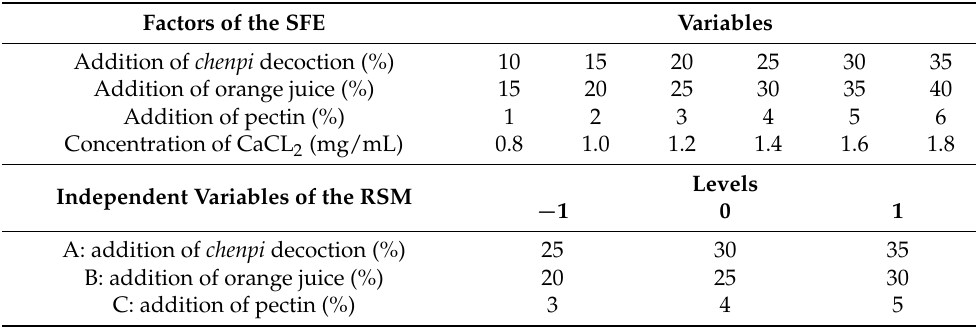
Table 2. Variables and the range of values for the SFE and RSM. Factors of the SFE Variables Addition of chenpi decoction